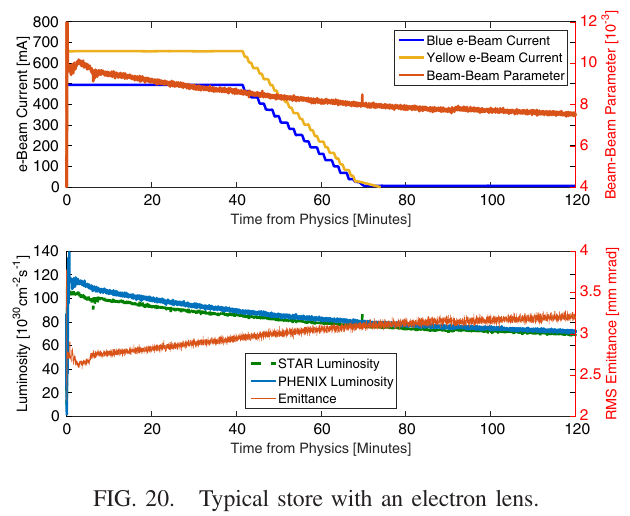
Yellow e-Beam Current Beam-Beam Parameter